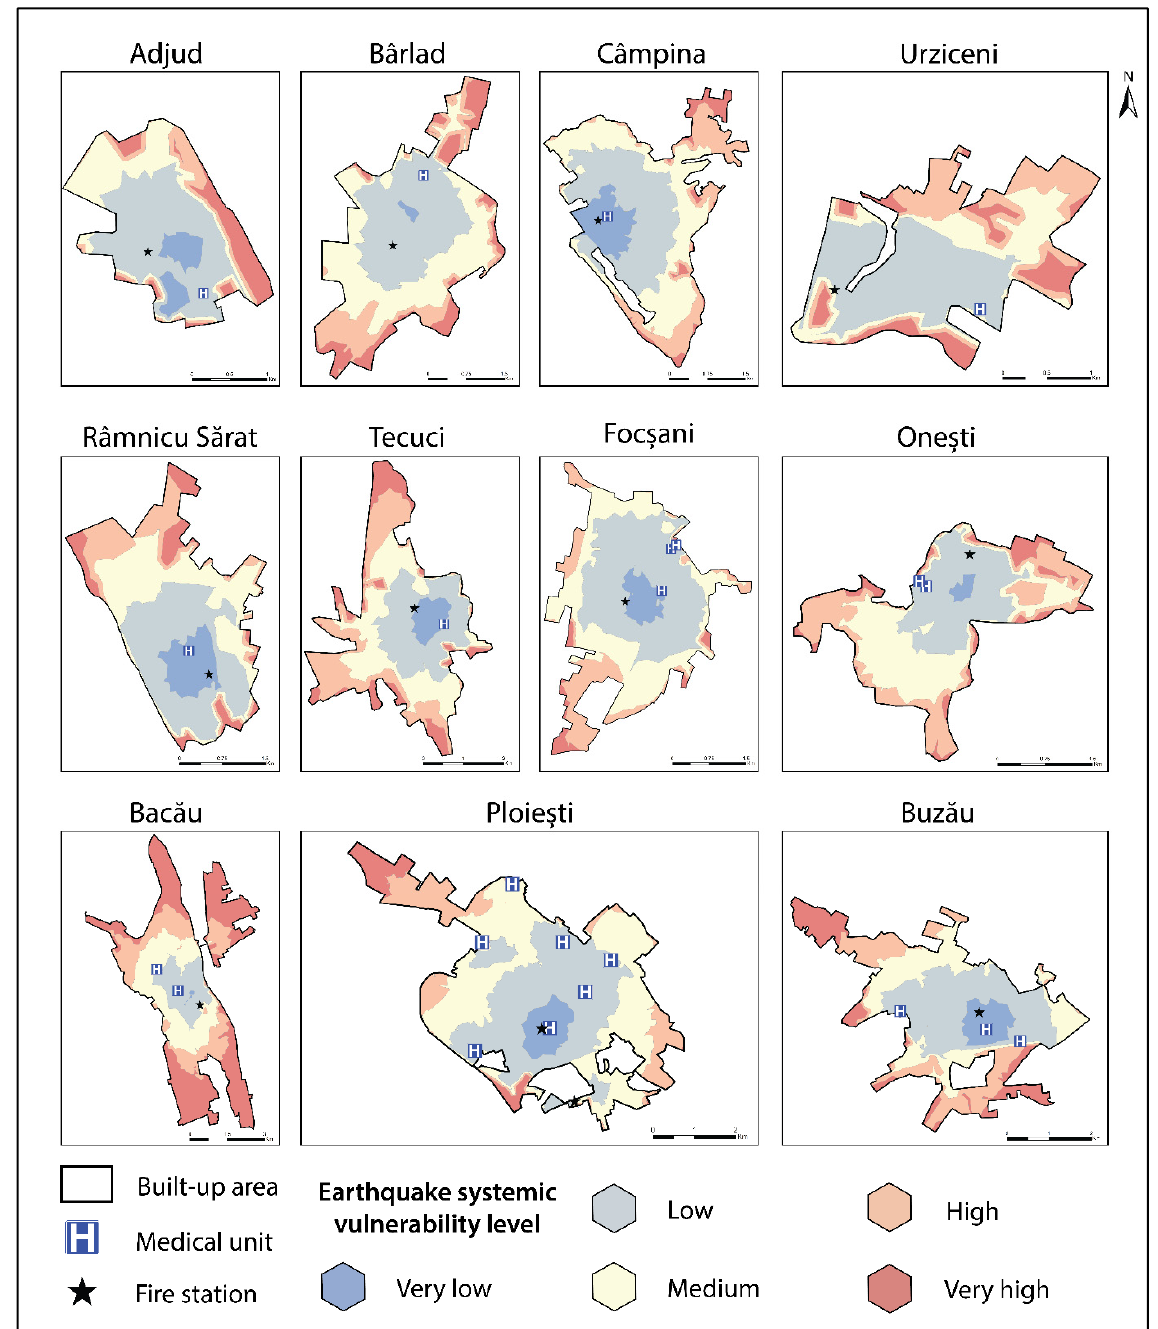
Figure 8. Earthquake systemic vulnerability maps of the 11 urban settlements. Vulnerability in- creases outward from the medical and fire management facilities. The scale was adapted for each urban settlement.